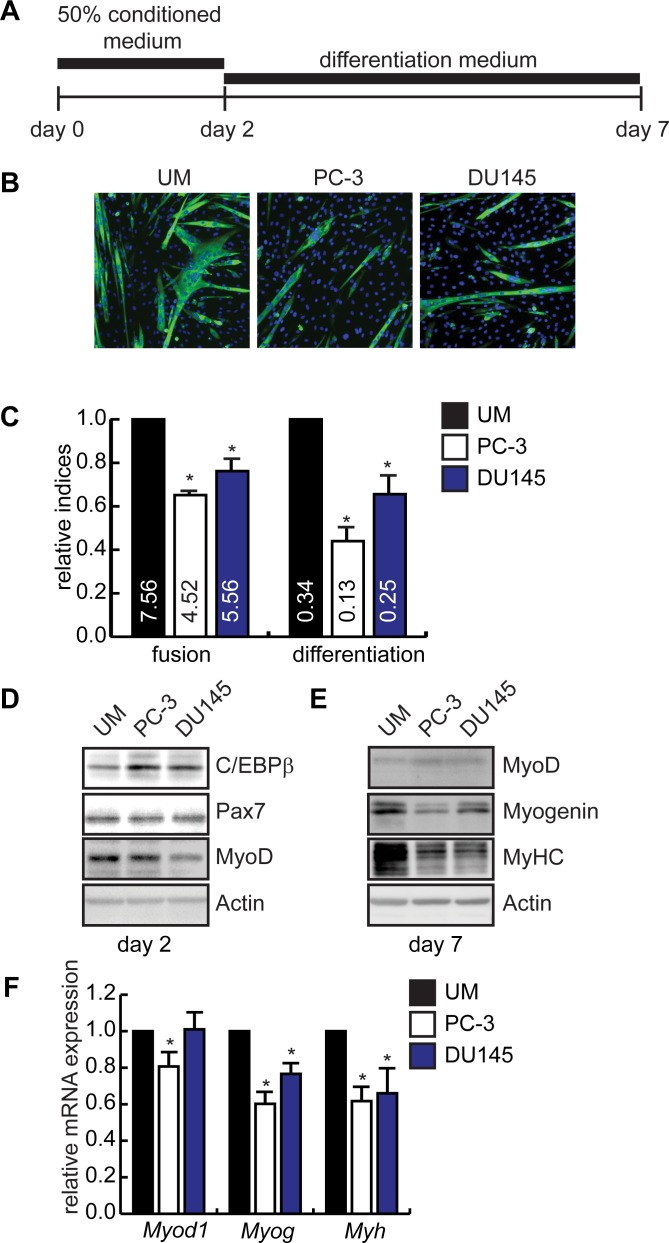
Pre-treatment with conditioned media from a prostate tumor inhibits skeletal muscle differentiation and upregulates C/EBPβ expression.
(A) Schematic of the treatment procedure for the tissue culture model of cachexia. Conditioned media from PC-3 cells was mixed 1:1 with fresh media, and was added onto proliferating C2C12 myoblasts for 48 hours after which cells were induced to differentiate in fresh DMEM containing 2% horse serum for 5 days. (B) Immunocytochemistry staining for myosin heavy chain expression in C2C12 cultures treated with conditioned media from PC-3 or DU145 prostate cancers or unconditioned media (UM) as in (A). DAPI stains nuclei blue. (C) C2C12 cultures were induced to differentiate as in (A) and the fusion index (#myonuclei/myotube) and differentiation index (#myonuclei/# total nuclei) was calculated, and shown relative to UM. Actual values are shown in the bars. *p<0.05, n = 7. (D) Western blot analysis of C/EBPβ, Pax7, and MyoD expression in proliferating C2C12 cells on day 2 after incubation with conditioned medium. Actin is a loading control. (E) Western blot analysis of myogenic marker expression in differentiated C2C12 cells on day 7. Actin is a loading control. (F) qRT-PCR analysis of Myod1, Myog and neonatal myosin heavy chain (Myh1, Myh2, Myh8, Myh13) expression, shown relative to cells treated with unconditioned medium (UM) on day 7. *p<0.05, n = 4.